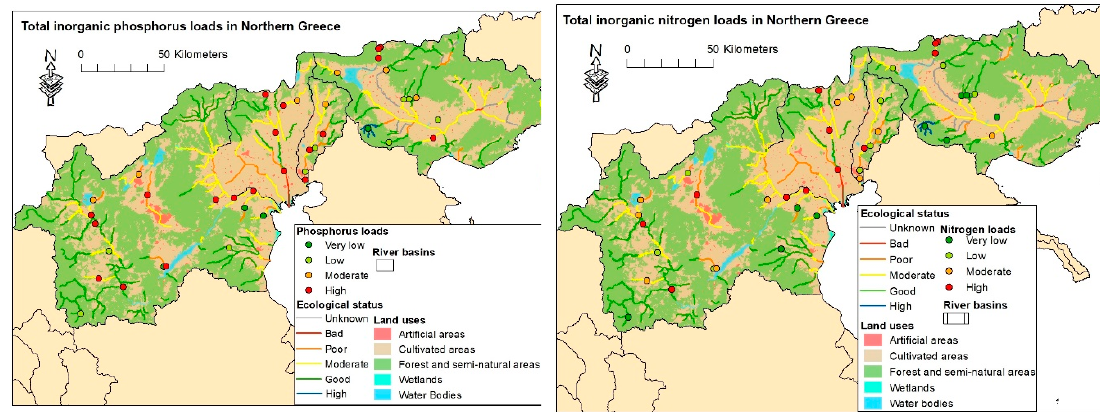
Figure 4. Maps are showing ecological classification of water bodies and classes of phosphorus loads ( left ) and total inorganic loads ( right ) in catchments of Northern Greece.